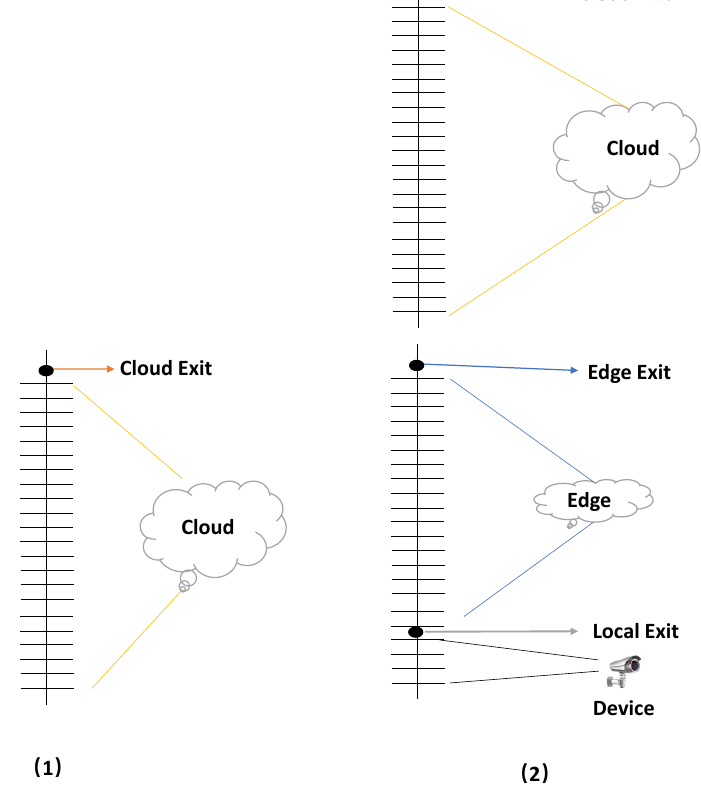
Figure 3. Conceptual model of the segmented neural network. Among them, Figure ( 1 ) is the cloud-based model, and Figure ( 2 ) is our improved layered model based on end devices, the edge and the